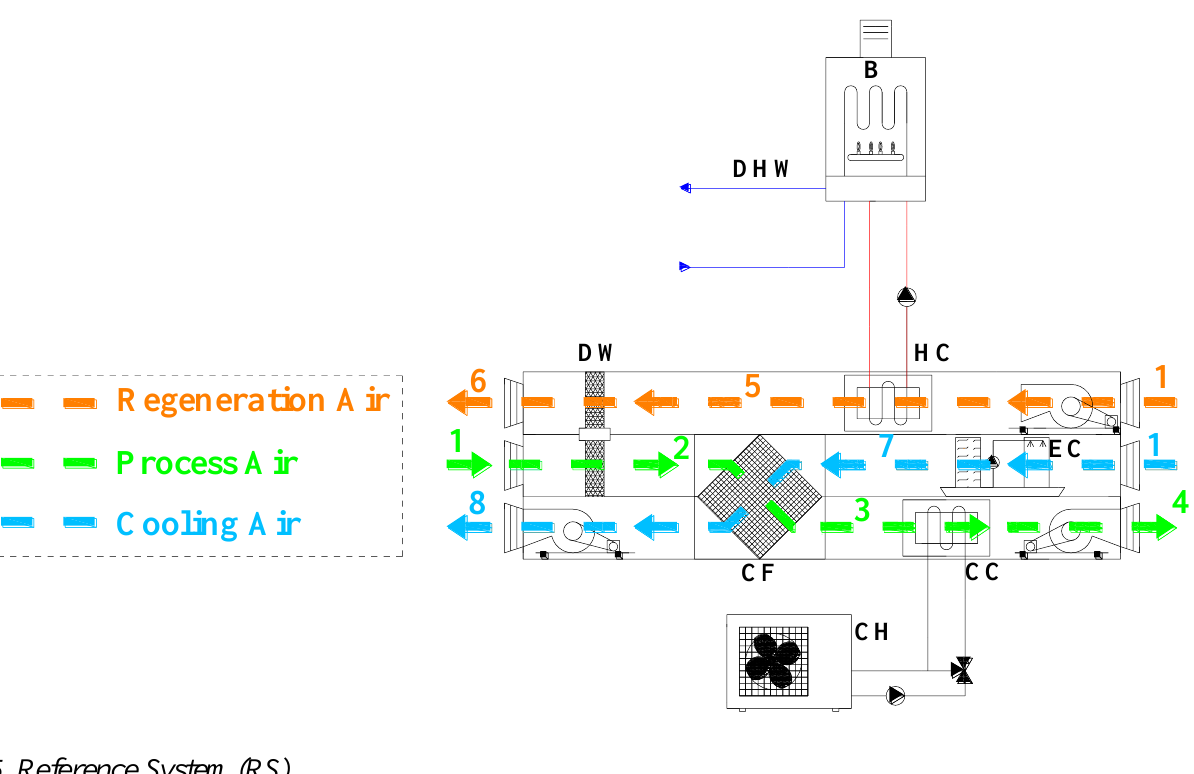
Figure 4. AHU layout for scenario D (natural gas